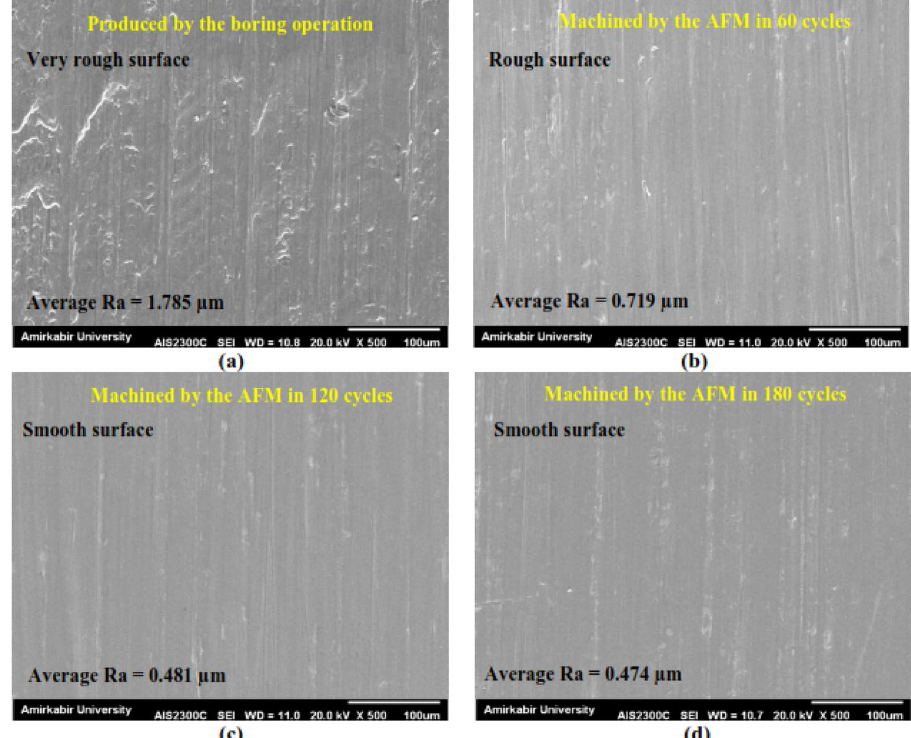
Fig. 5 SEM images of AA2024 tubes at the different number of AFM cycles: a 0, b 60, c 120, and d